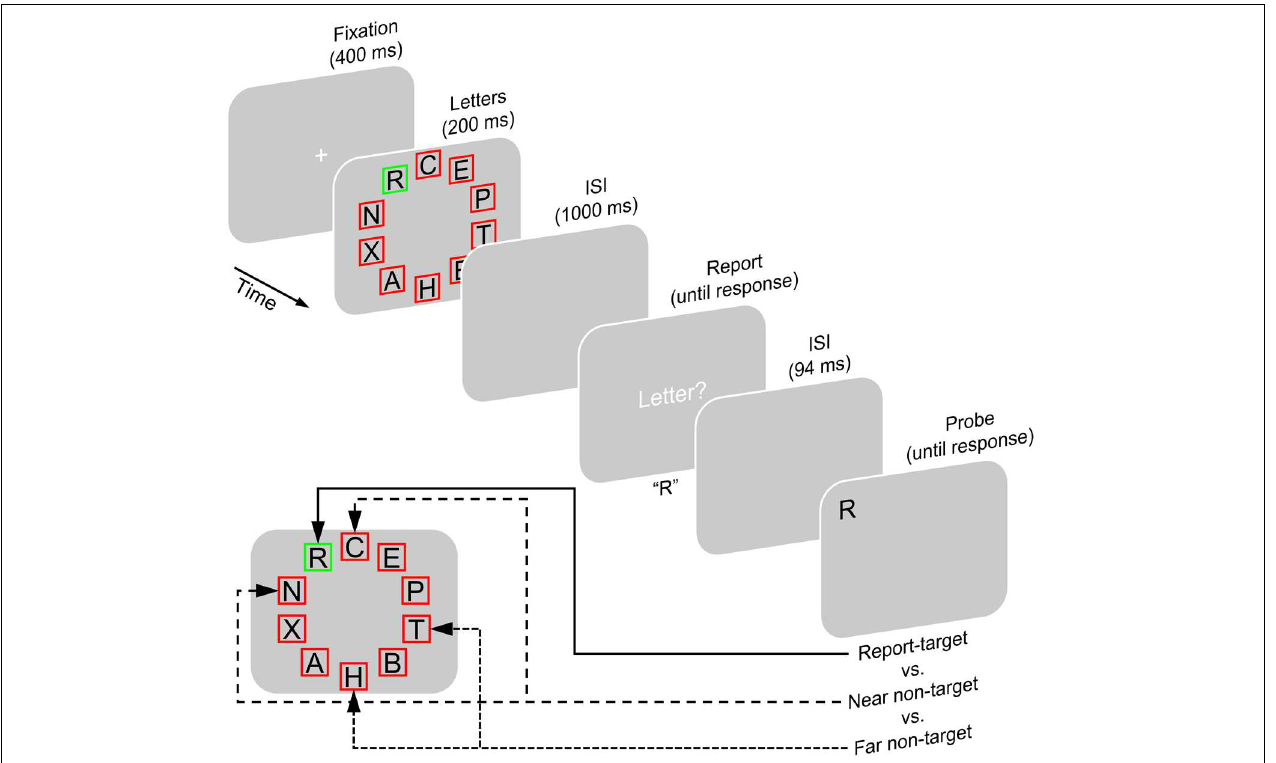
FIGURE 4 | Experimental paradigm of Experiment 2. In the beginning of each trial, a fixation cross was shown, after which a display of letters appeared. Each letter was located inside a red or green square. One square differed in its color from the others indicating the report-target, which was to be reported when a response screen appeared after an ISI. Letters in squares of the other color were not to be reported (non-targets). After another ISI, a single probe letter was shown. Then, participants indicated whether or not this probe has been shown as part of the letter display in this trial. The probe either (1) tested the report-target (i.e., was shown at its position and either matched it or had not been presented on this trial; report-target condition), (2) or it tested one of the letters flanking the report-target (near non-target condition), or (3) it tested one of the two letters opposite to the letters flanking the report-target (far non-target